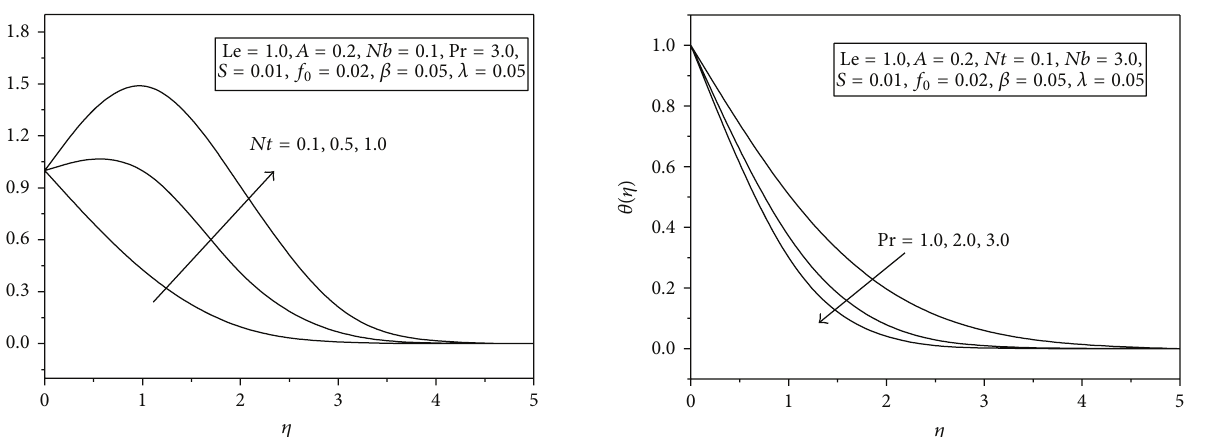
Figure 14: Temperature profile for different values of Pr.